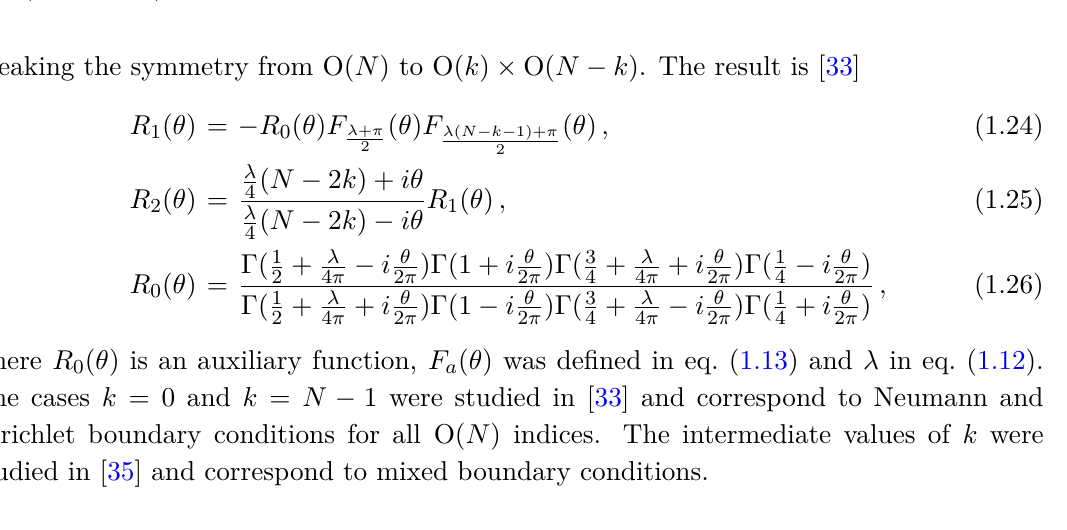
Figure 2 . Physical region of the reflection process ( Re ε ≥ 0 ). The positive real axis corresponds to the physical reflection ( ε ∈ R ) which is the boundary value of an analytic function in the ≥ m physical region (shaded). Crossing can be imposed on the upper line, this is the minimal region where crossing gives a constraint. Boundary bound states could appear as poles on the imaginary axis (dashed line) but we do not allow them